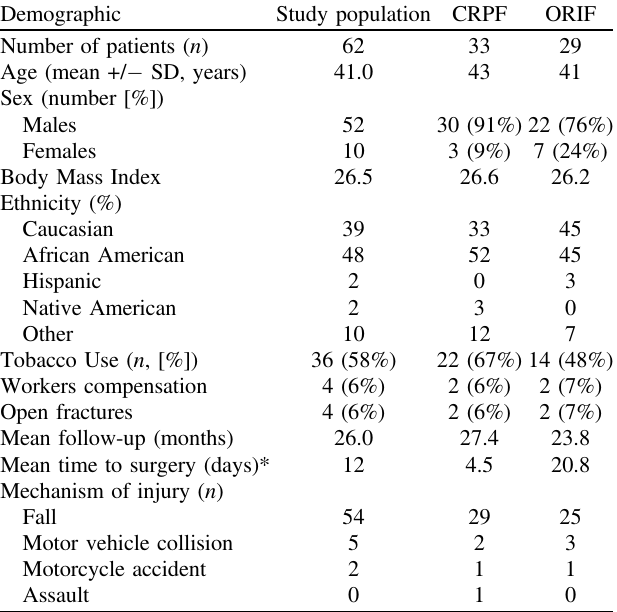
Table 1. Patient demographics and mechanism of injury of intra-